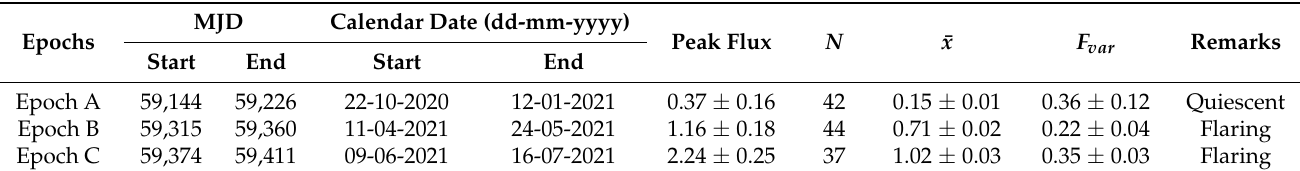
Table 1. The epochs considered for the γ -ray light curve study are listed in the table below. Here, N , ¯ x , and F var denote the total number of data points, the average γ -ray flux, and the fractional variability amplitude, respectively, for the epoch. The γ -ray flux is in the units of 10 − 6 ph cm − 2 s − 1